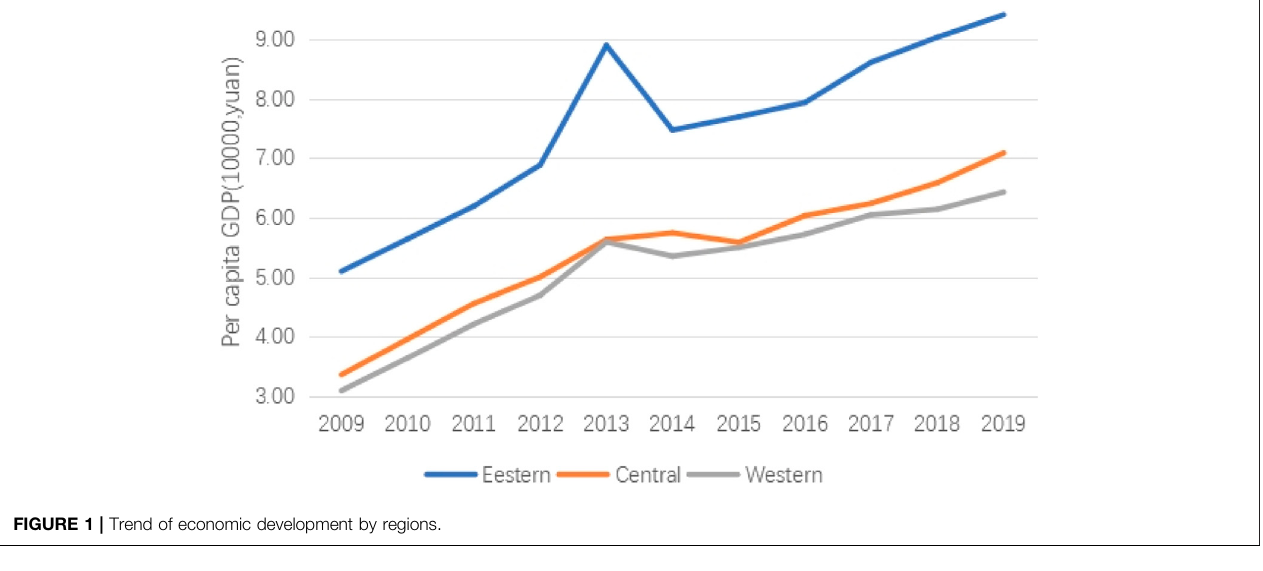
FIGURE 1 | Trend of economic development by regions.